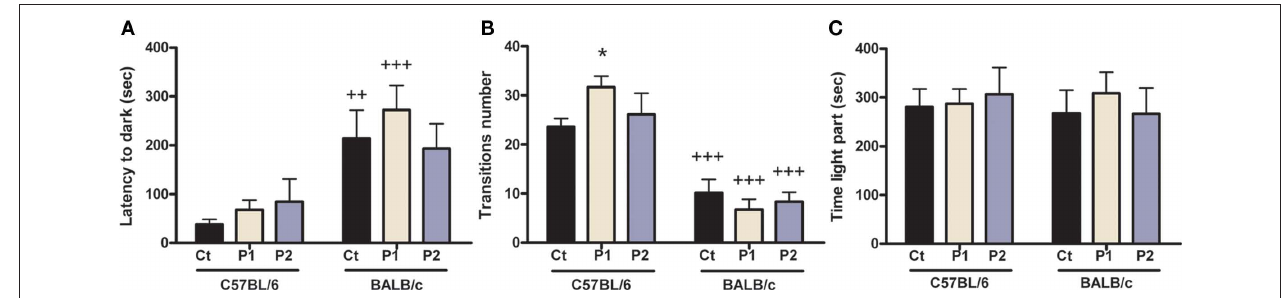
Figure 5 | effect of MS on anxiety behavior in the light/dark box. MS had no overall effect in either of the two strains in latency do dark (A) and time in the light part (C) . However, MS protocol 1 C57BL/6 mice displayed increased number of transitions (B) than control animals. There were also strains differences with control and protocol 1 C57BL/6 mice displaying lower latency to